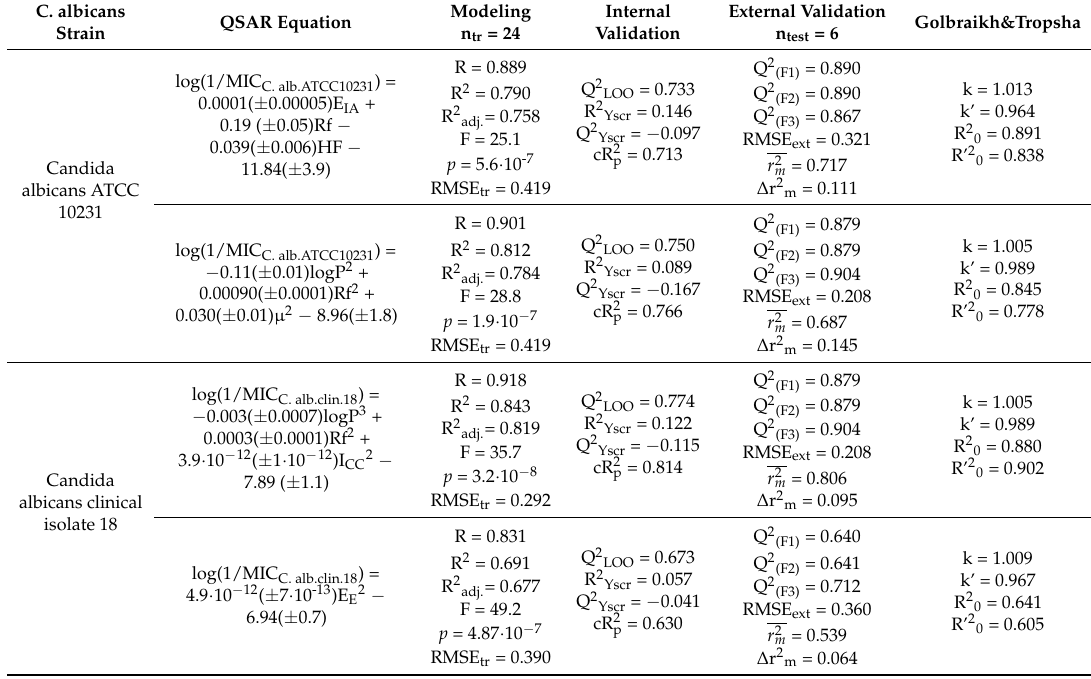
Table 2. Formulas describing the relationship of activity against Candida albicans ATCC 10231, Candida albicans clinical isolate 18 and molecular descriptors (training set = 80% of whole dataset, test set = 20% of whole